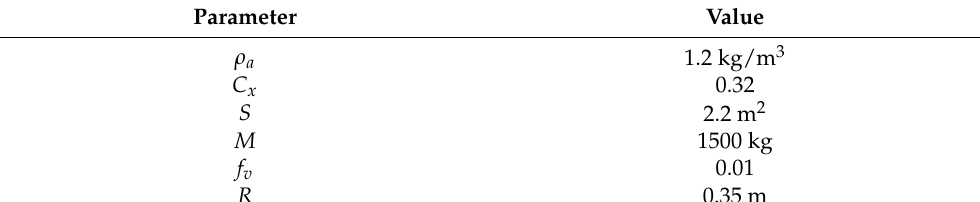
Table 1. Vehicle parameters.